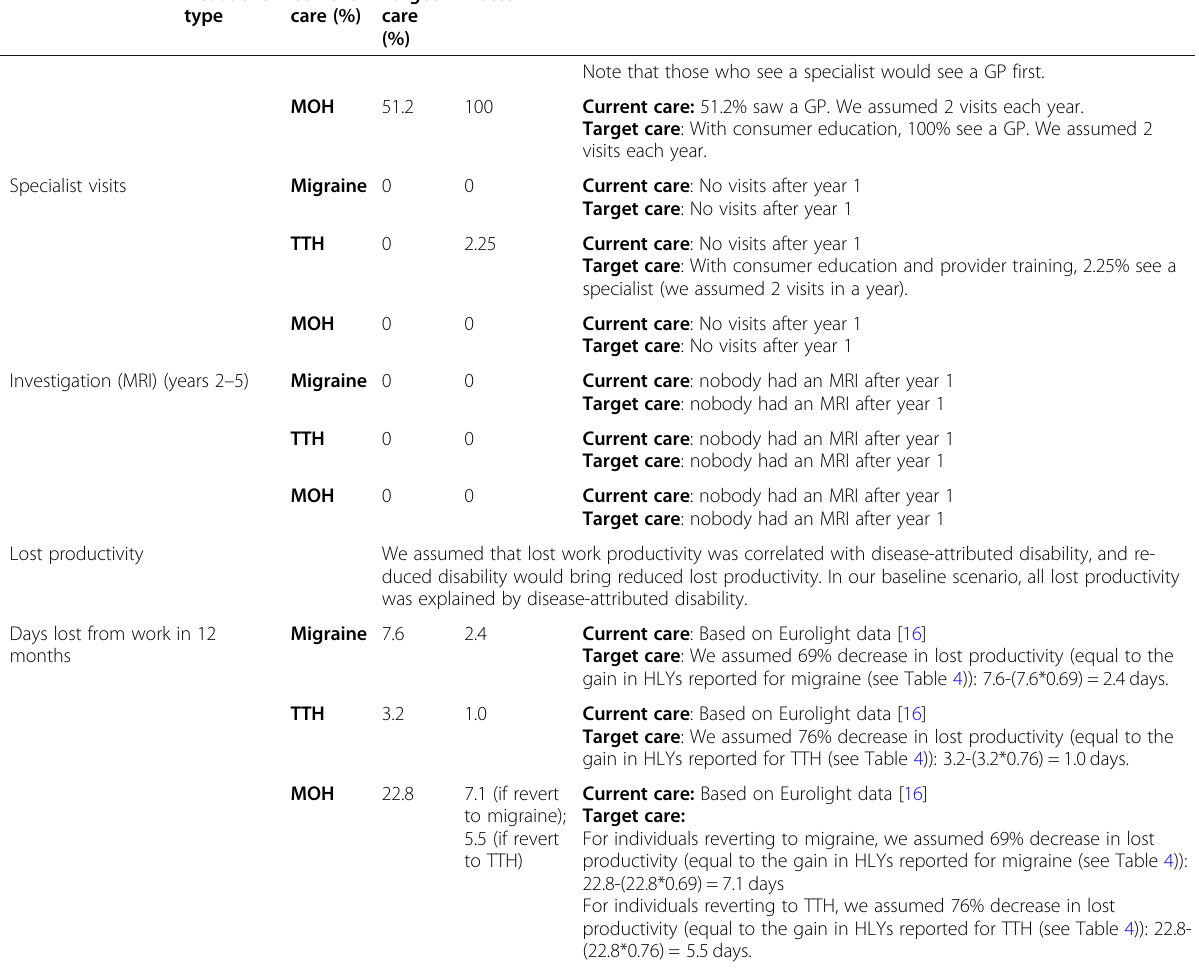
Table 1 Treatment uptake, use of resources and lost productivity according to treatment management plan (Luxembourg)